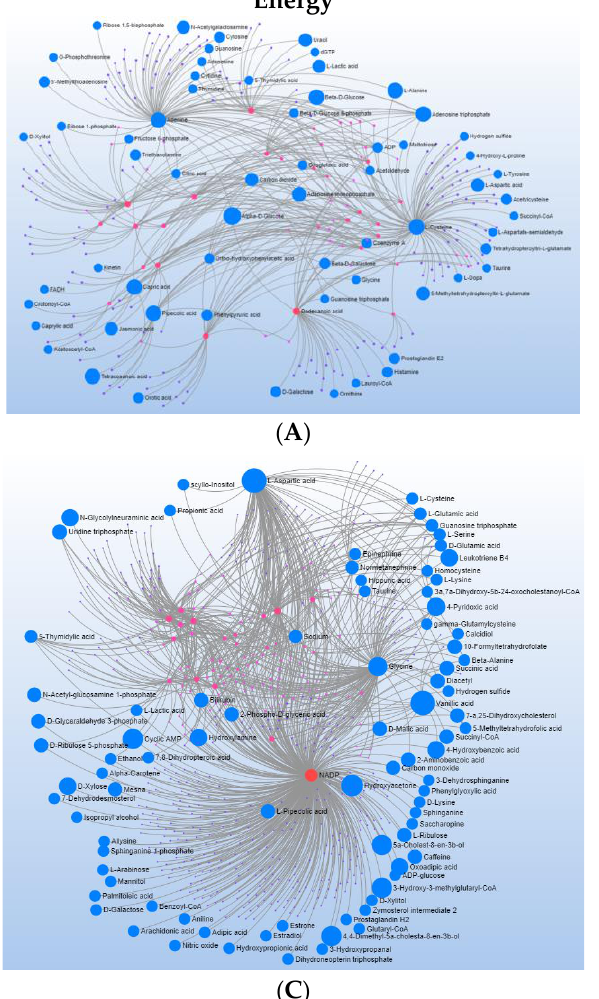
Energy Amino Acid